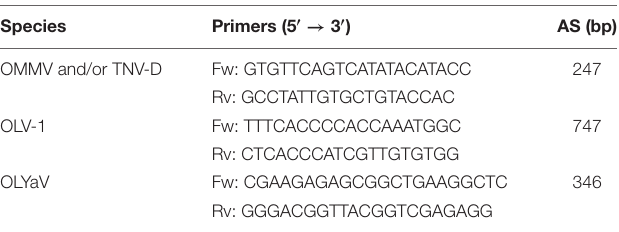
TABLE 1 | Primers used on conventional PCR assays.